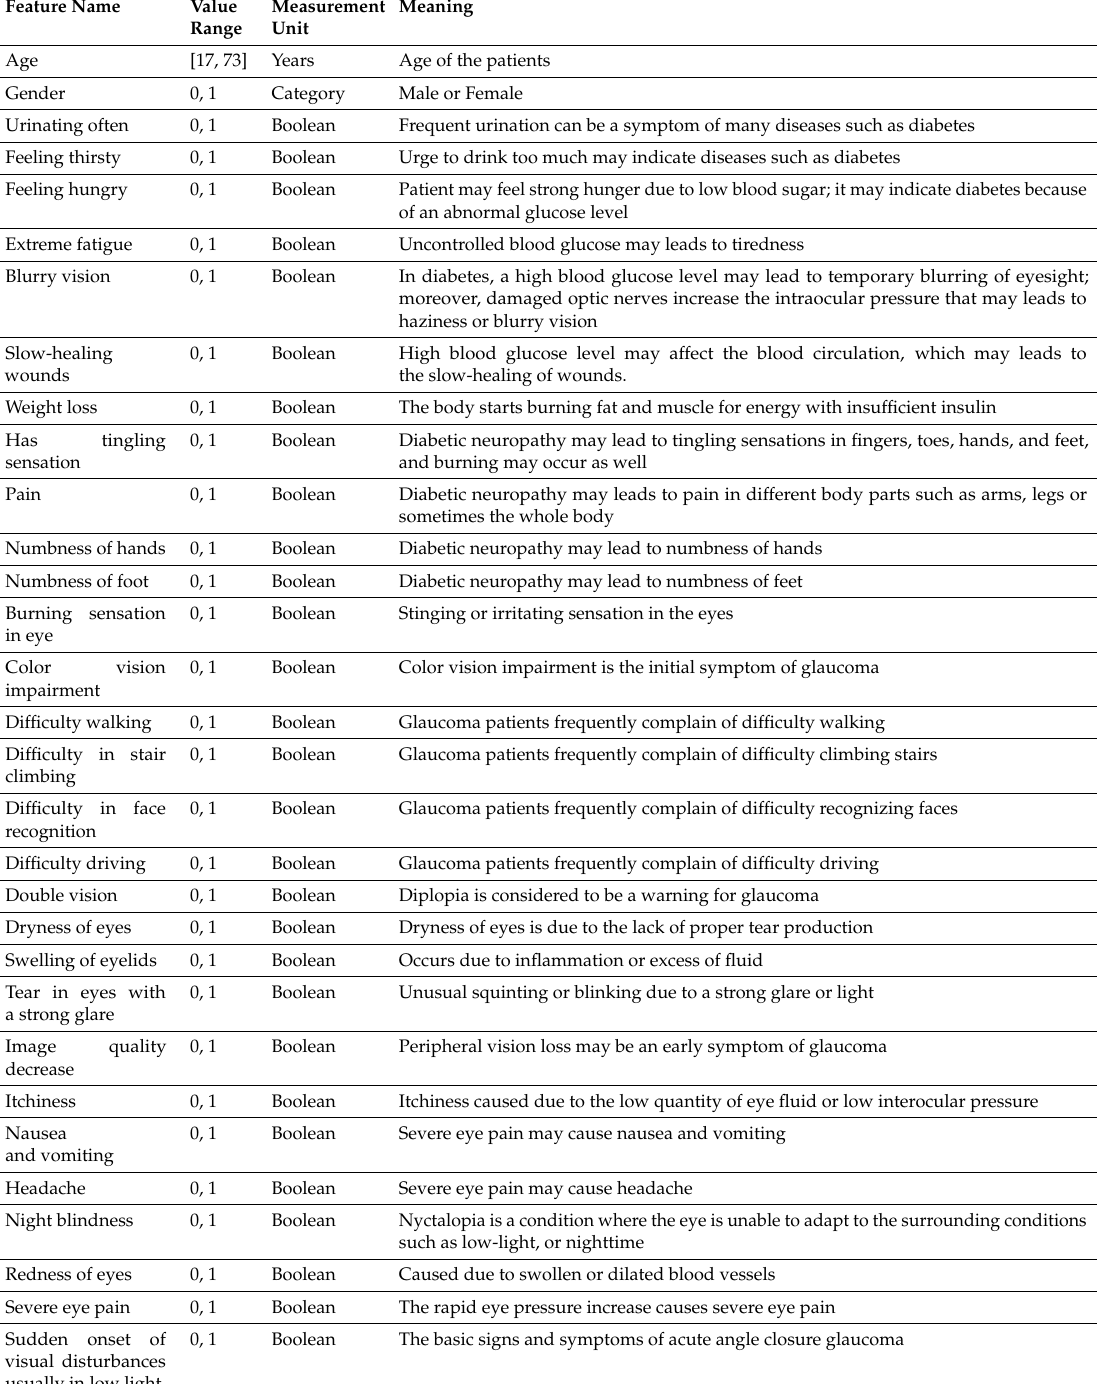
Table 2. MIRA Dataset features with ranges, measurement units, and meaning of each